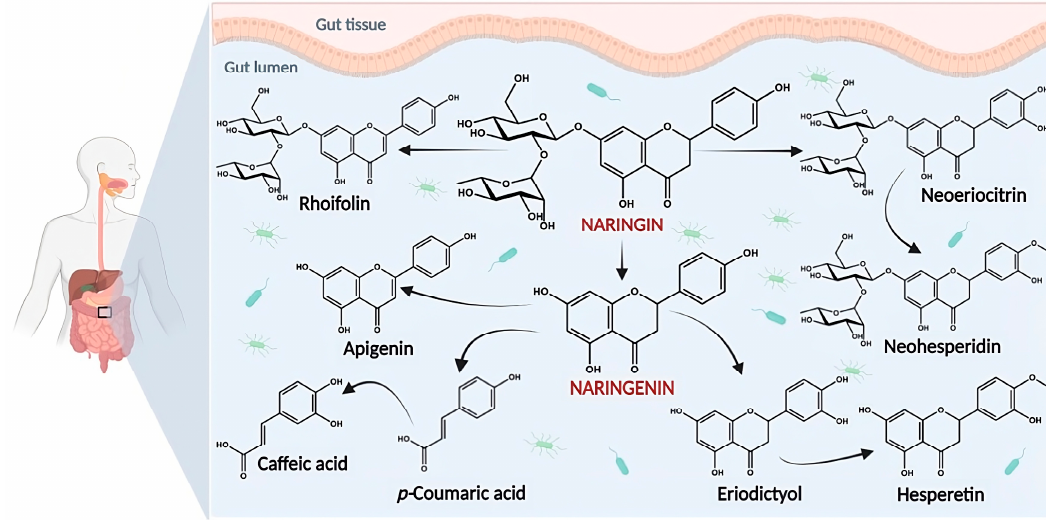
Figure 4. Some potential pathways for the metabolism of NRG by the gut microbiota.